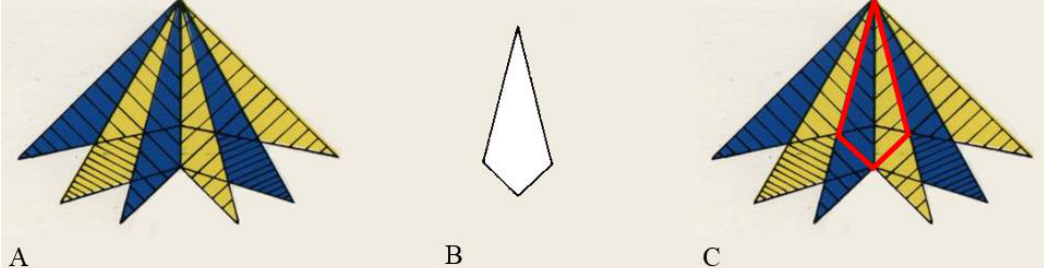
Figure 1. An example of an item taken from the Embedded Figure Test (EFT). ( A ) The geometric colored complex figure. ( B ) The simple black and white simple shape. ( C ) The simple shape within the complex figure.